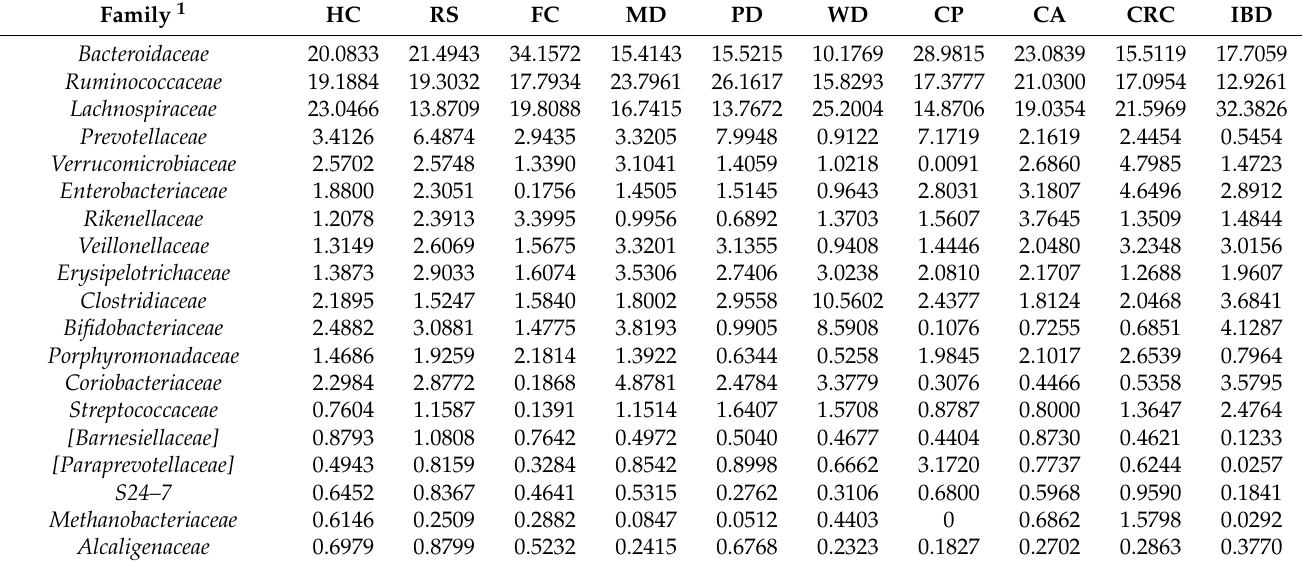
Figure 2. Microbiota composition of the different groups. Relative abundance of the most represented ( A ) phyla and ( B ) families. Groups: Healthy subjects (HC), subjects at risk of developing colorectal cancer (RS), healthy familiars of IBD patients (FC). Subjects following a Mediterranean (MD), modern Paleolithic (PD), or Western-like diet (WD). Patients with colon polyps (CP), colon adenoma (CA), colorectal cancer (CRC), Crohn’s disease (CD), and ulcerative colitis patients (UC). Table 3. Average OTU composition (%) of the different groups at family